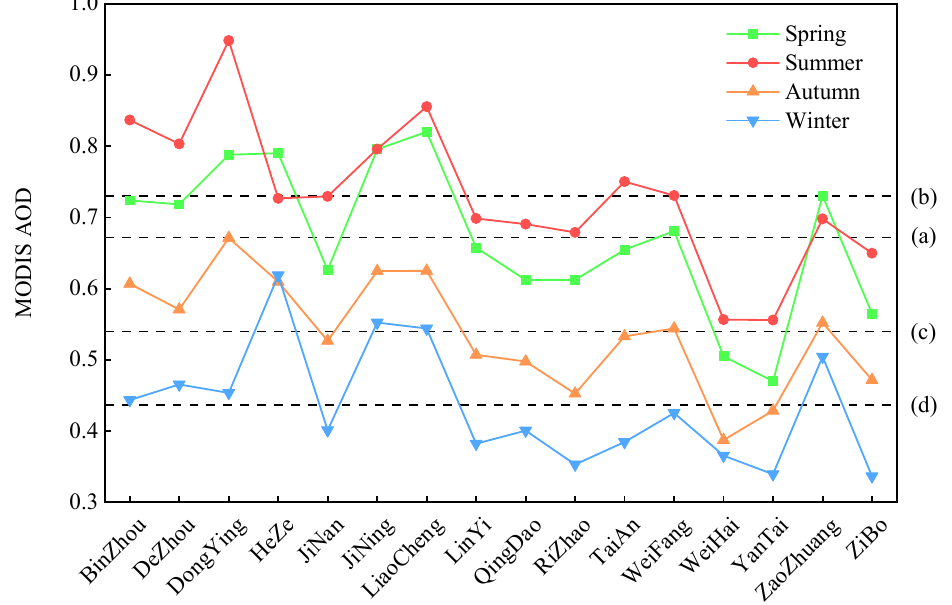
Figure 4. Variations of quarterly AOD by prefecture level cities in Shandong Province: AOD values of Shandong Province in ( a ) spring, ( b ) summer, ( c ) autumn and ( d ) winter.